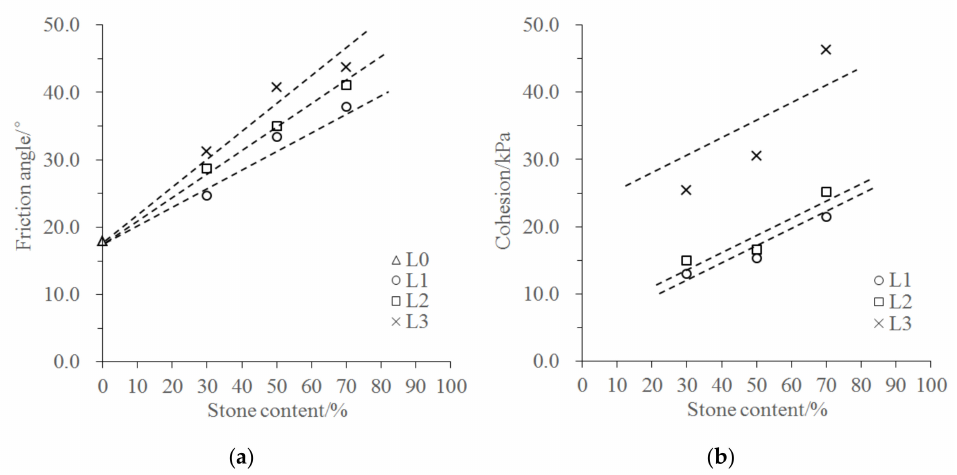
Figure 13. Parameters of shear strength versus the stone content of SRM. ( a ) Friction angle versus stone content; ( b ) cohesion versus stone